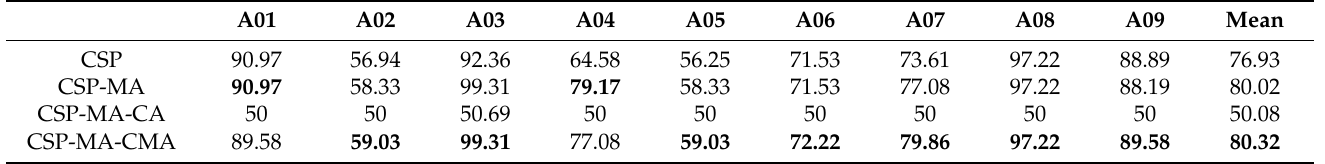
Table 2. Comparison of accuracies (%) using different alignment methods on dataset 2.